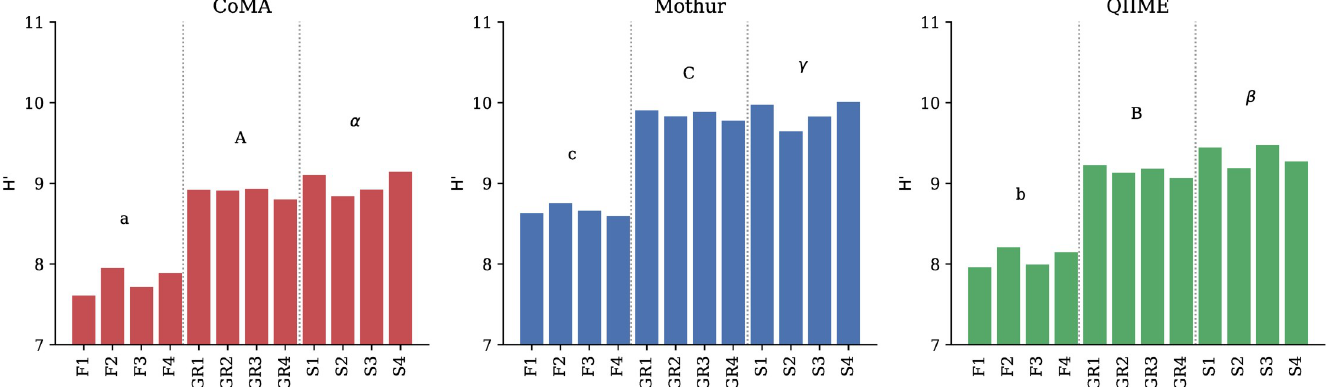
Fig 5. Shannon-Wiener diversity (H’) of the three different soils after sequencing data analysis with CoMA, Mothur and QIIME. Four replicates for each habitat are shown. Letters indicate significant differences across the analysis tools for each habitat. F = forest. GR = grassland. S = swamp.